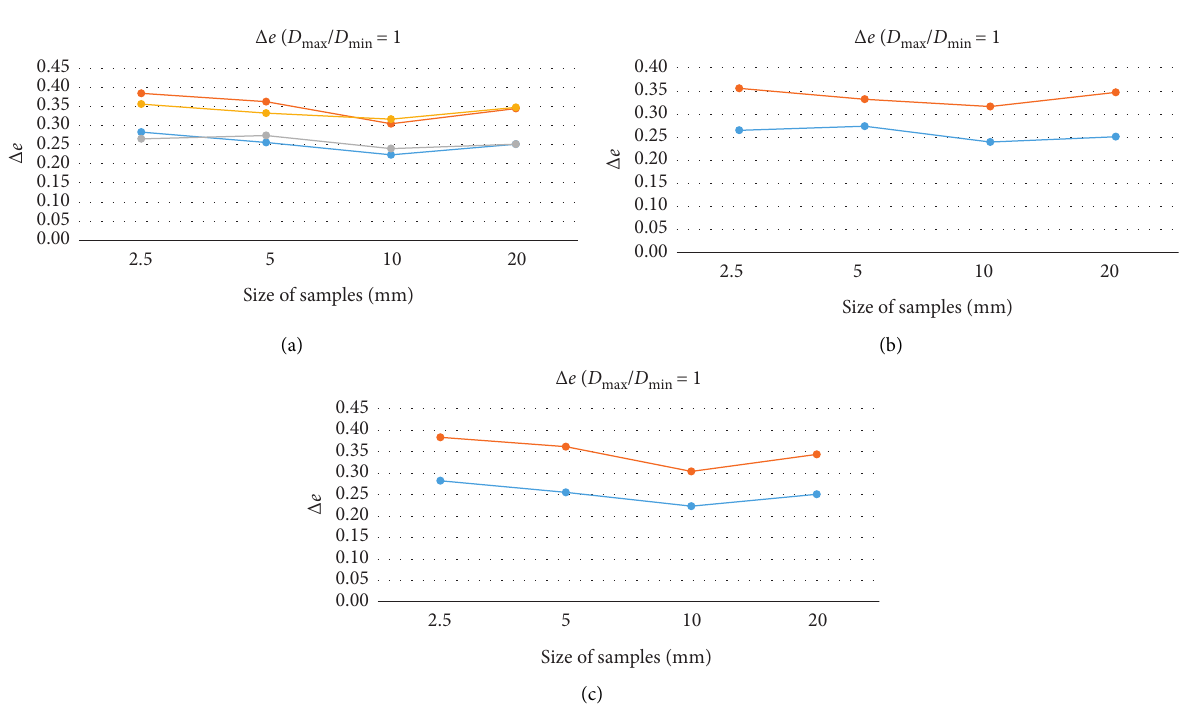
Figure 13: Difference in porosity ratios between loose and dense materials with uniform granulation by funnel and spoon precipitation, sudden precipitation, and comparative